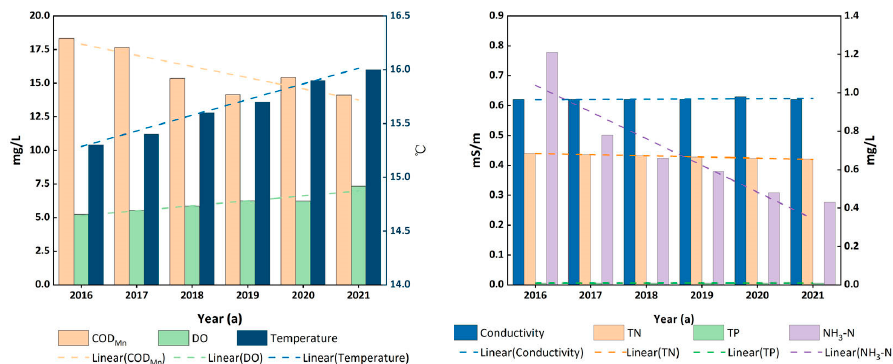
Figure 4. Analysis on inter-annual variation of water quality of typical wetlands in the source region of the Yangtze River.